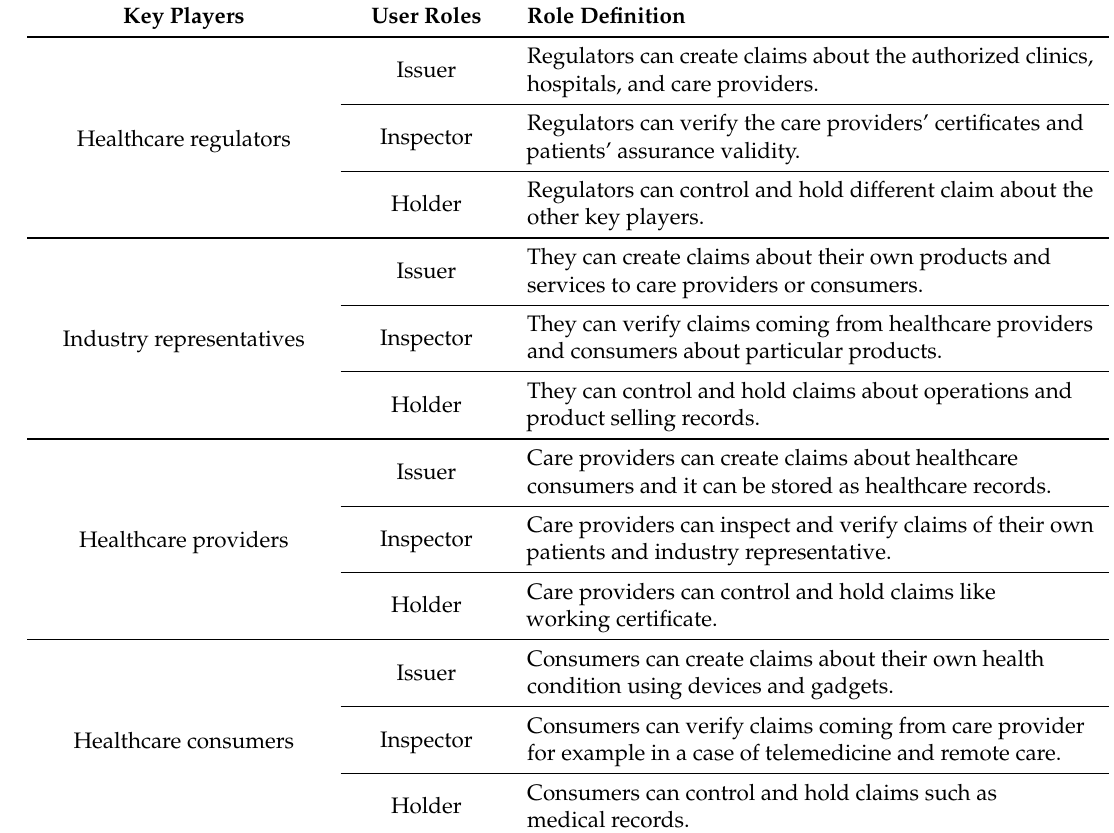
Table 3. Key players’ roles and